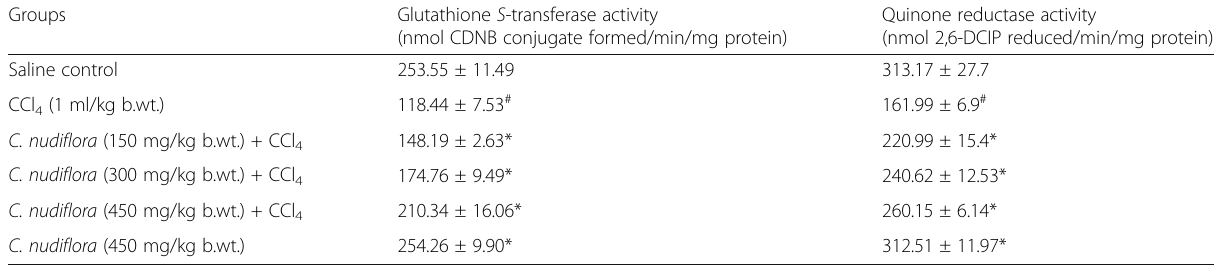
Table 4 Effect of C. nudiflora on CCl 4 -induced changes in phase II metabolizing enzymes Groups